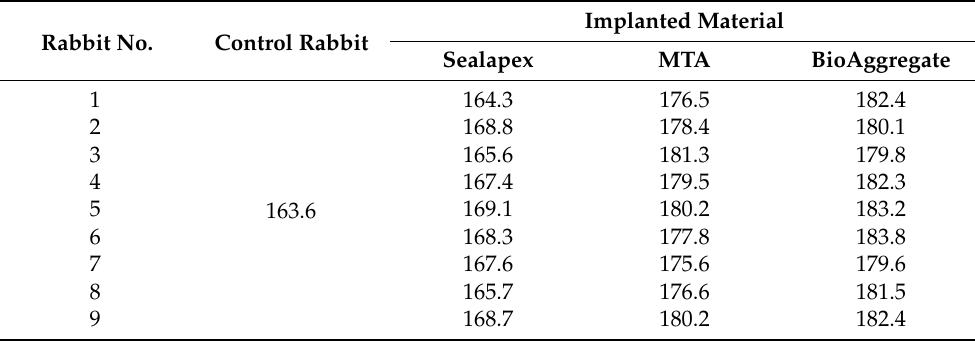
Figure 11. Rounded bone deposits: osteoblasts with intense osteogenic activity are present in the bone traverse (Bio Aggregate).